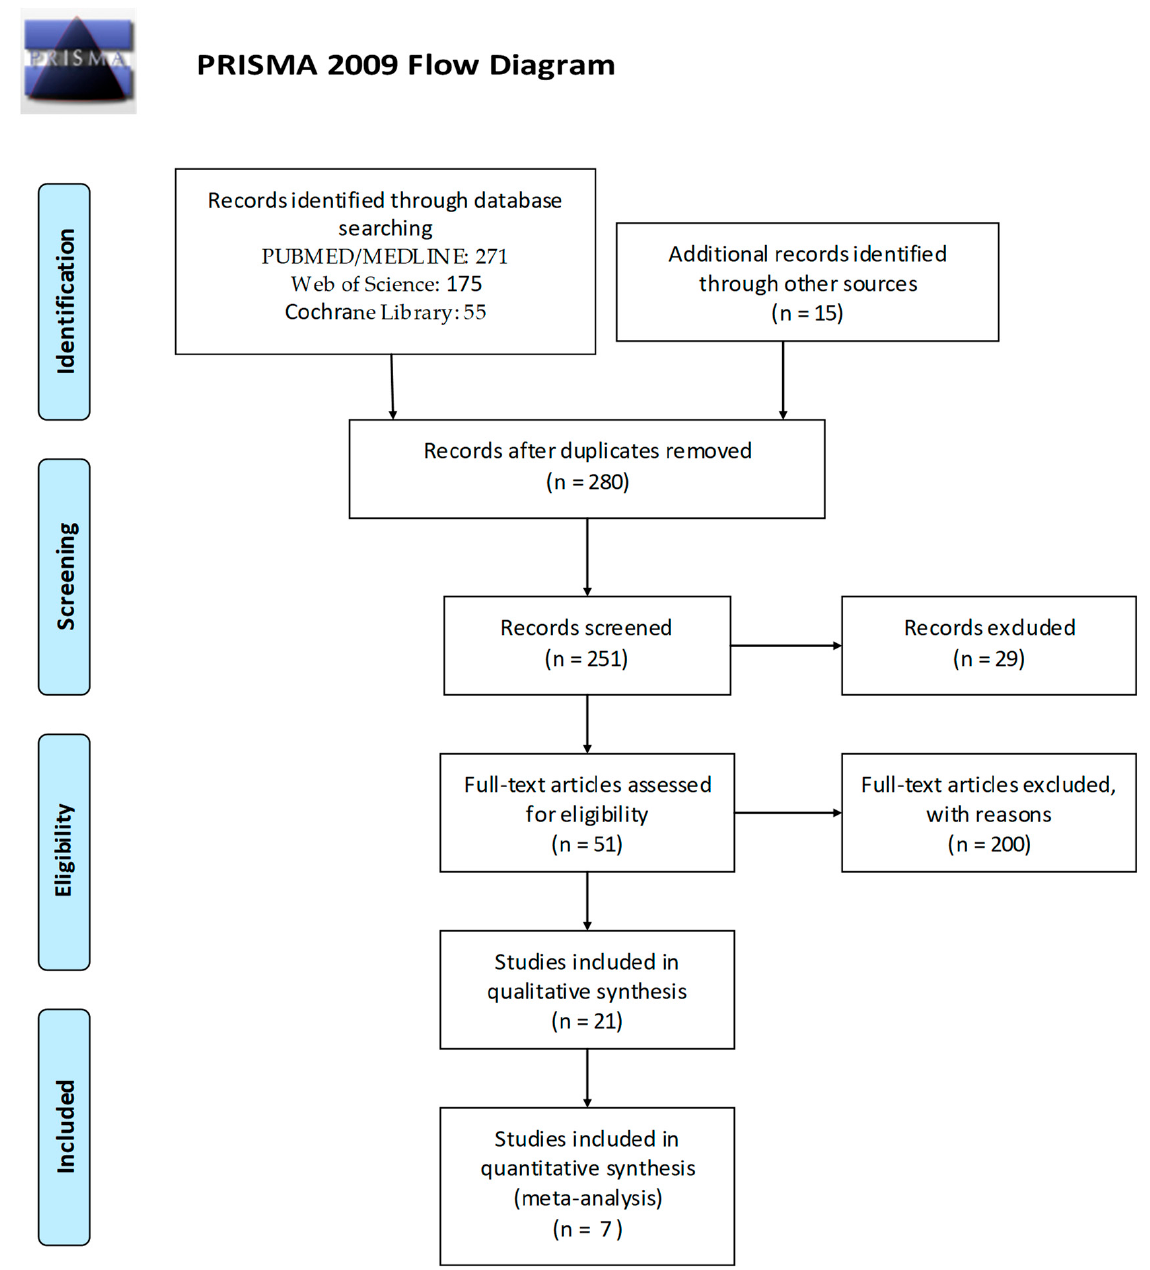
Figure 1. PRISMA flow diagram